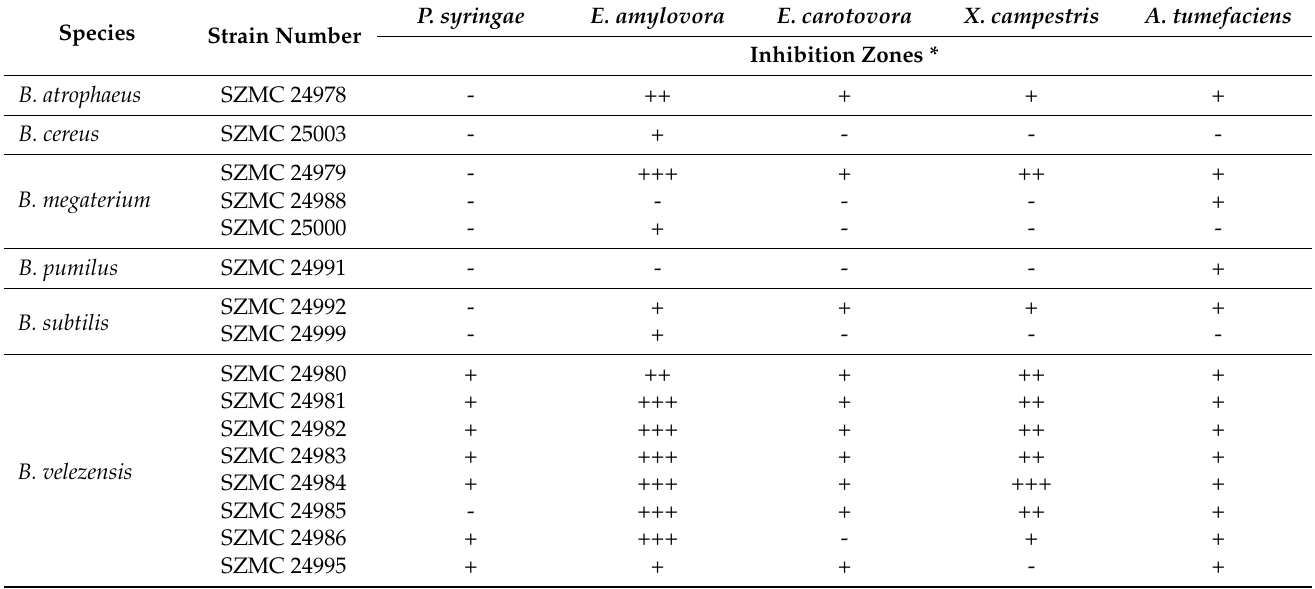
Table 3. Inhibition of bacterial pathogens by isolates.